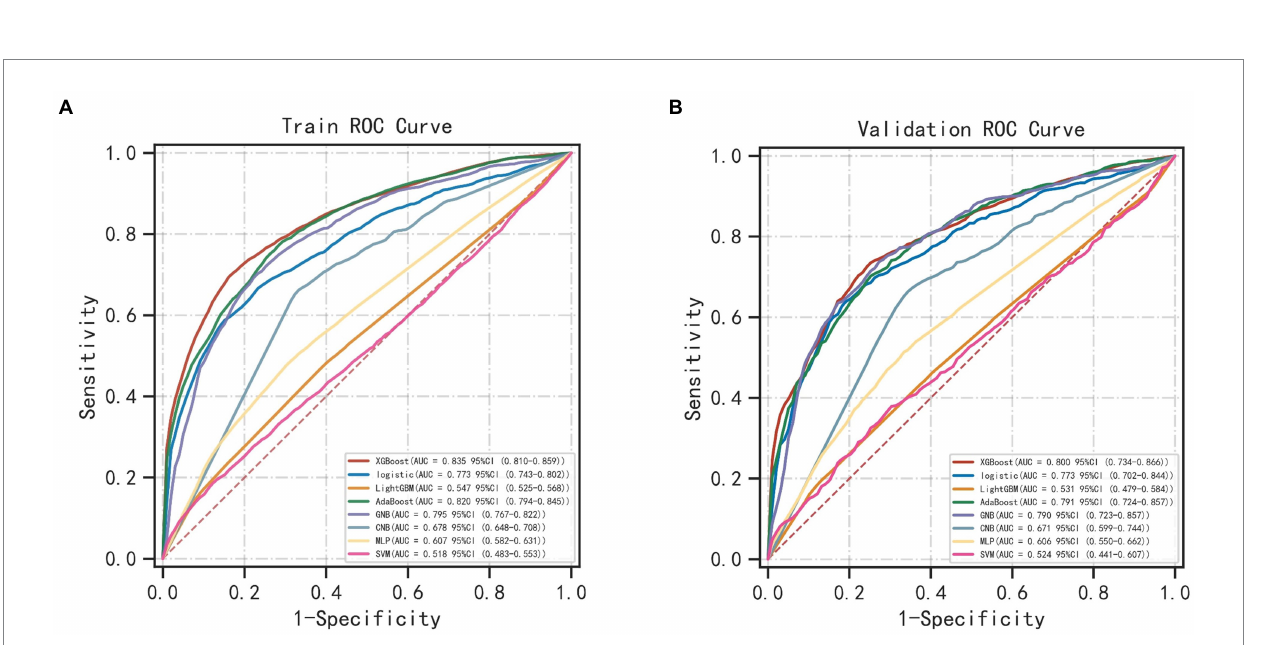
FIGURE 4 DCA (A) and calibration curve (B) of the XGBoost and simplified model. DCA, decision curve analysis; XGBoost, eXtreme Gradient Boosting.